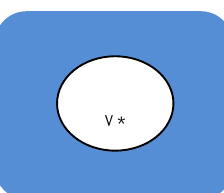
Figure 1. Schematic of self-consistent model of representative volume element (RVE).